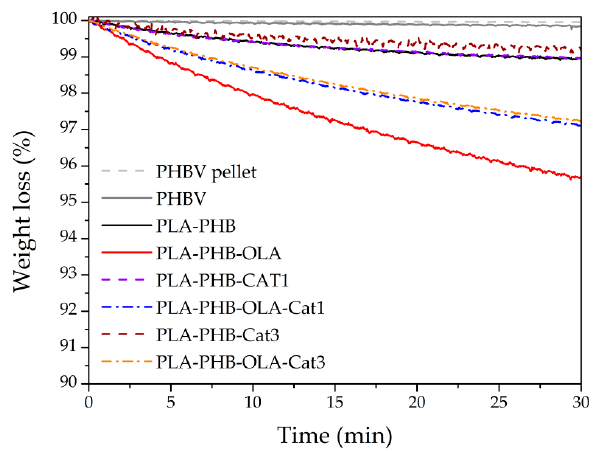
Figure 2. Isotheral thermogravimetric analysis (TGA) at 150 ° C of electrospun mats.